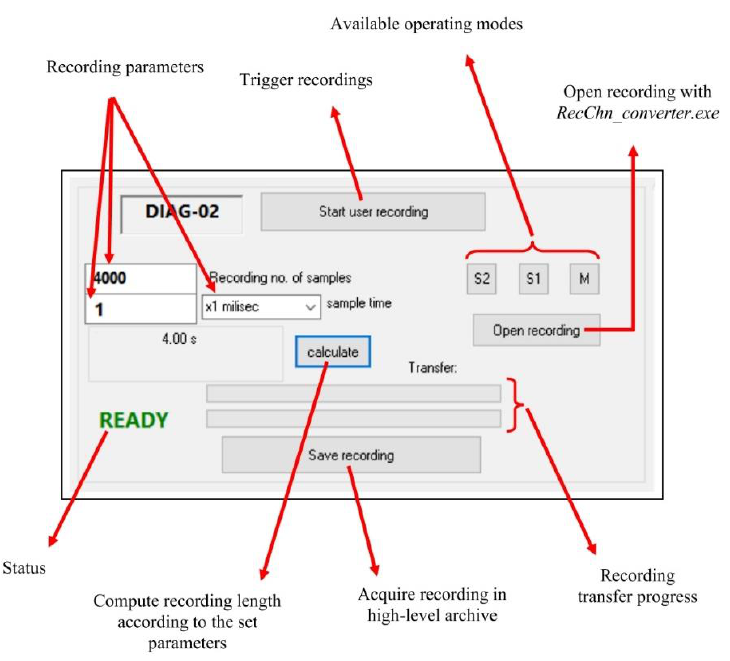
Figure 10. High-level graphical interface command